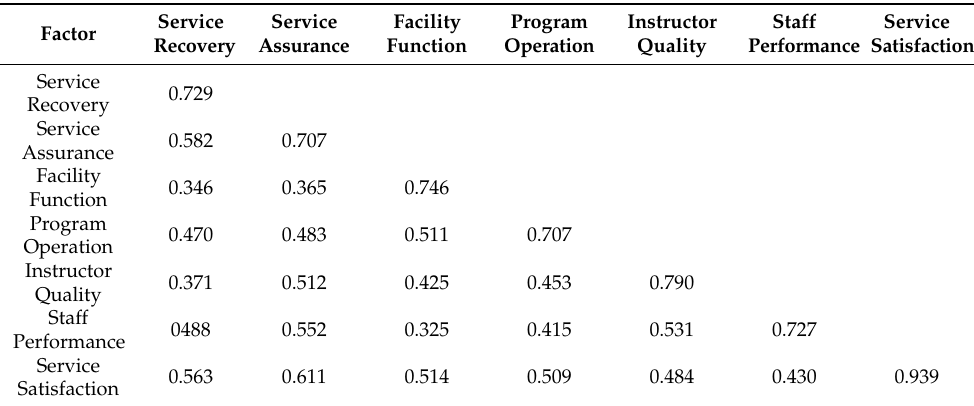
Table 6. Discrimination Validity of the Retained SFCS